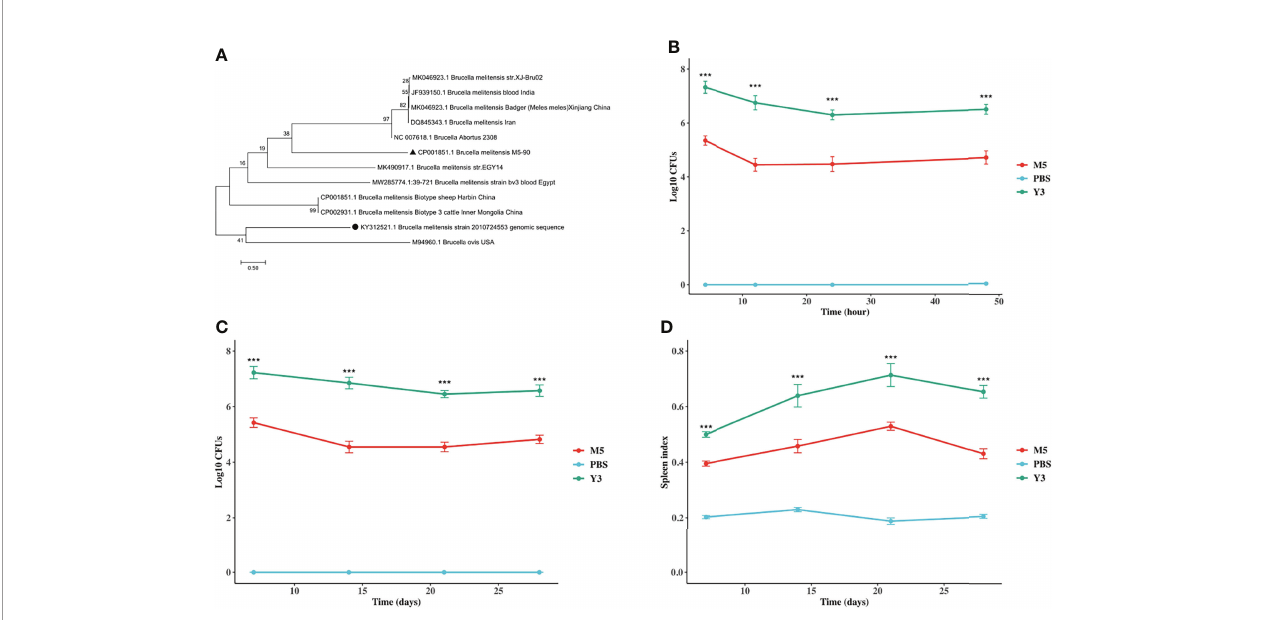
FIGURE 1 | Investigation of the phylogeny of B. melitensis biovar 3 and B. melitensis M5-90, and identi fi cation of survivability of B. melitensis biovar 3 and B. melitensis M5-90 in vitro and in vivo . (A) Phylogenetic tree of the IS 711 concatenated sequence of B. melitensis biovar 3 ( ● ) isolated from milk or aborted sheep fetuses in a previous study and reference sequences from B. melitensis retrieved from the GenBank database. The black triangle ( ▲ ) represents Brucella melitensis M5-90. The tree was constructed according to the neighbor-joining (NJ; 500 bootstrap replicates) and maximum-likelihood (ML, 1000 bootstrap replicates) analyses using MEGA7. The scale bar represents the inferred substitutions per nucleotide site; (B) RAW264.7 cell lines were infected with B. melitensis biovar 3 or B. melitensis M5-90 for 4, 12, 24, 48h. The CFU was determined on TSA at each time point; (C) The Balb/c mice were infected with B. melitensis biovar 3 or B. melitensis M5-90 and PBS (negative control) with four mice in each group. At 7, 14, 21, 28 days post-infection, the spleen was isolated and individual spleens were assessed for colonization and weight index (D) . Splenic weight was calculated as organ weight (in grams) per gram of mouse body